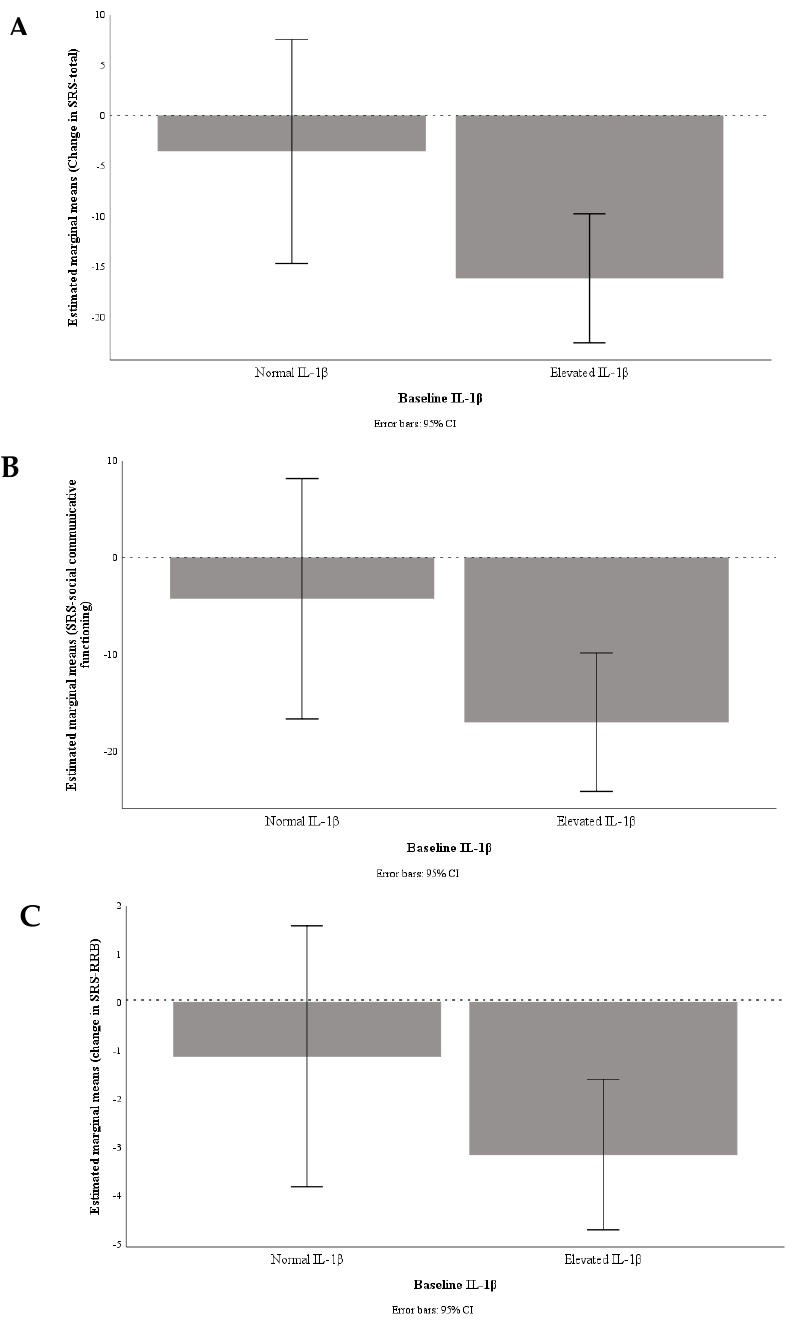
Figure 1. Graphical presentation of change in SRS-total ( A ), SRS-social communicative functioning ( B ), and SRS-repetitive and restricted interests and behaviours (RRB) ( C ) by baseline inflammation status; undetectable / normal, IL-1 β < 3.2 pg / mL ( n = 14) vs. elevated, IL-1 β ≥ 3.2 pg / mL ( n =